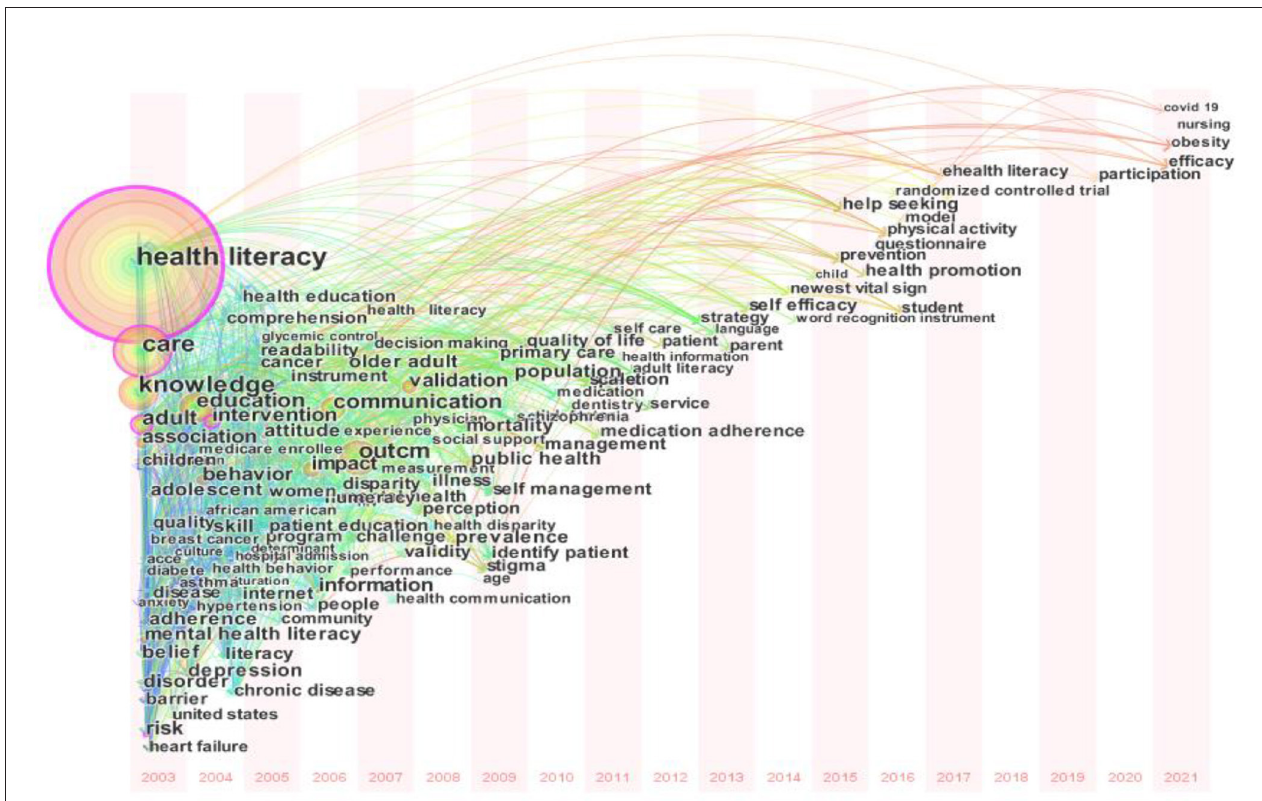
FIGURE 8 | Time-zone map of co-occurring keywords network on health literacy